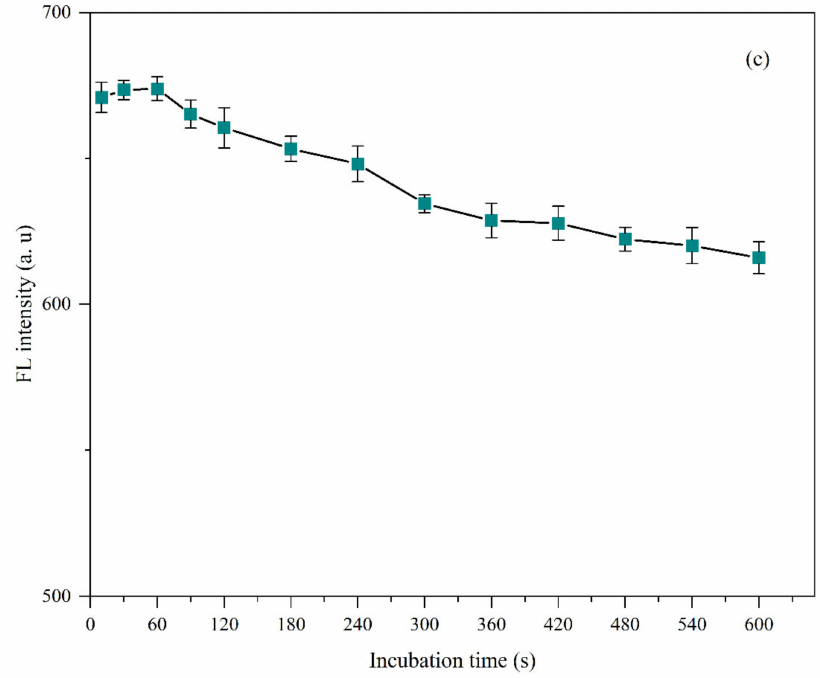
Figure 5. Effect of various pH ( a ), fluorescence platform content ( b ), and incubation time ( c ) of